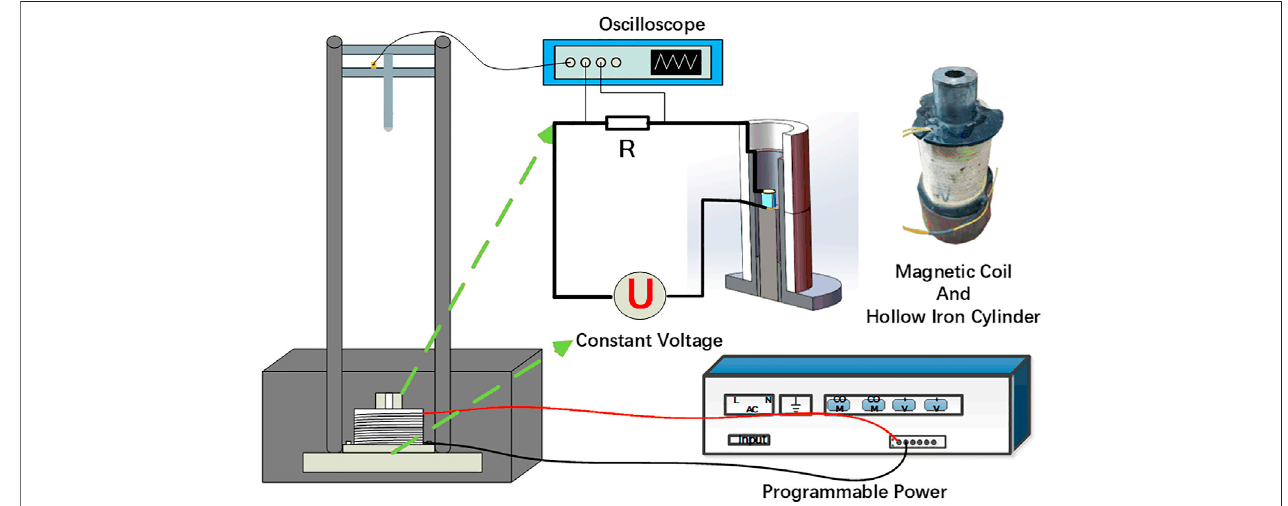
FIGURE 4 | Schematic of the test equipment and measuring method.